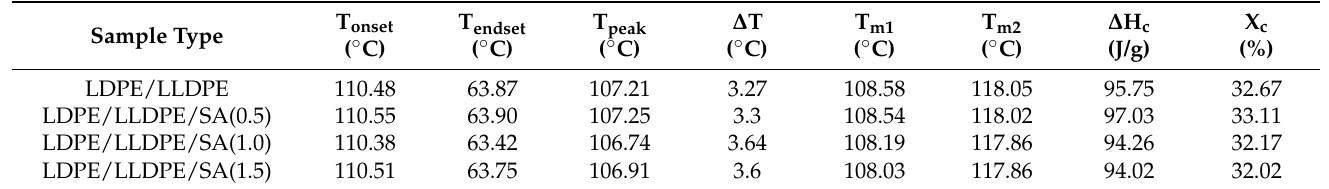
Table 4. The DSC analysis data for the LDPE/LLDPE binary blend and LLDPE/LDPE/SA (0–1.5%) air blown composite films.